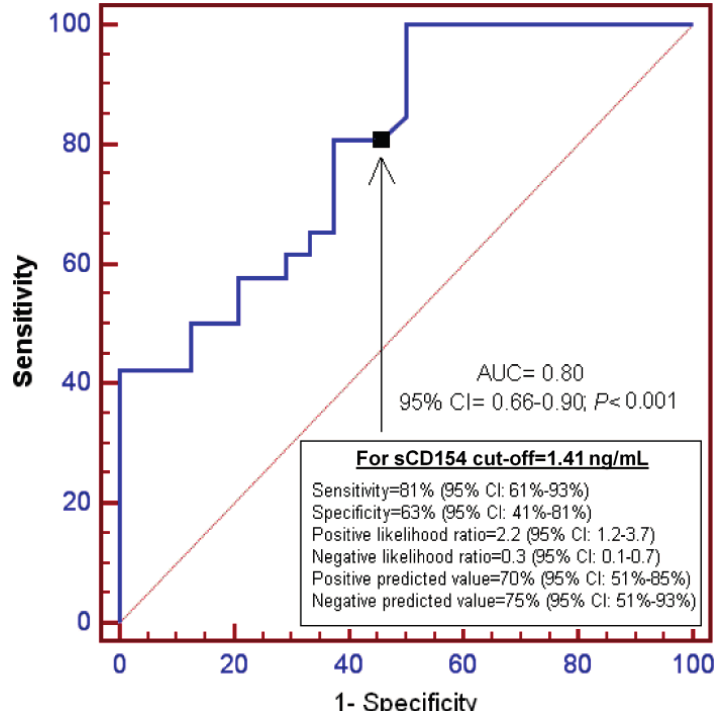
Figure 2. Receiver operation characteristic analysis using serum sCD154 levels as predictor of mortality at 30